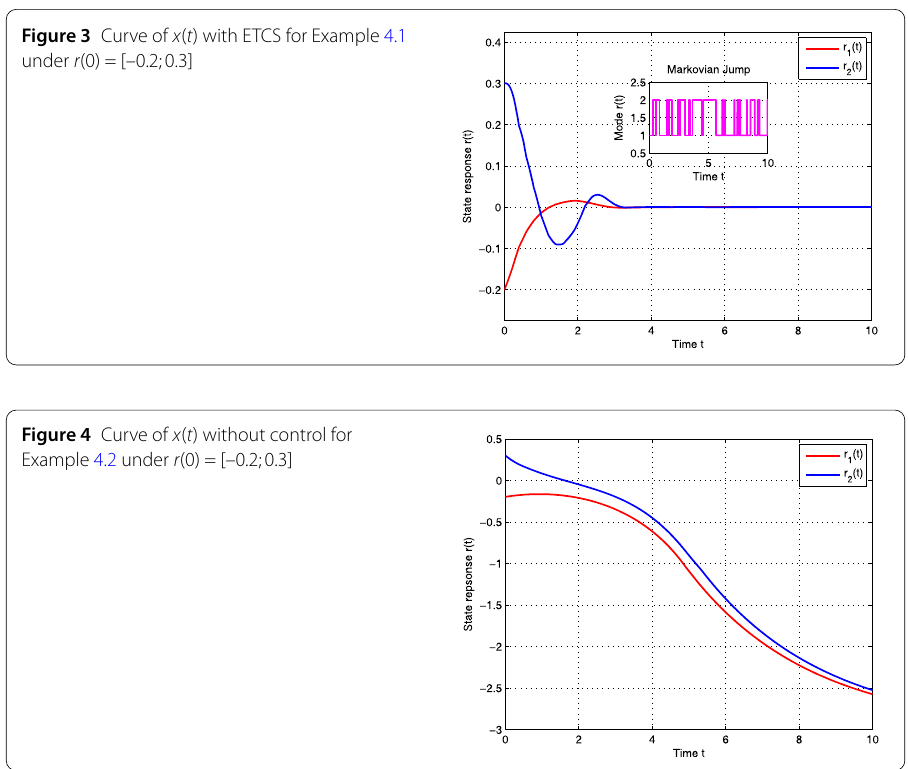
Figure 4 Curve of x ( t ) without control for Example 4.2 under r (0) =